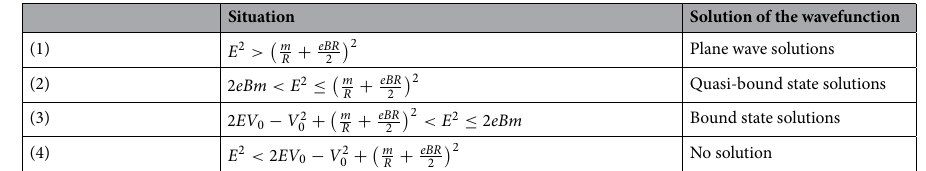
Table 1. Relation between the effective potential U eff and effective energy E eff , indicating the four situations corresponding to different kinds of wavefunction solutions; notably, quasi-bound states exist in situation (2).